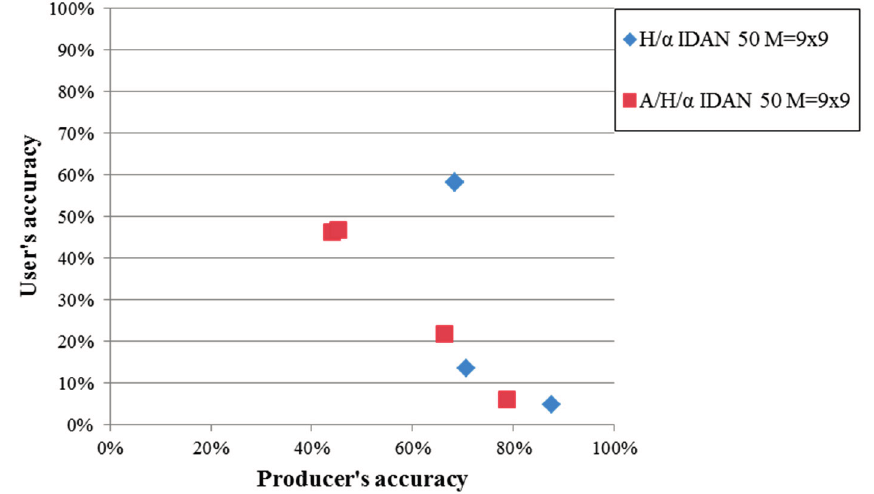
Figure 11. Development of user’s accuracy vs. producer’s accuracy for the OBIA improvements based on H/ α or A/H/ α , respectively (for the second TerraSAR-X acquisition (19 October 2010)). Processing steps from lower right to upper left: (1) pixel-based, (2) first s-e, (3) rule-set, (4) second s-e. Please notice that the third and fourth point are located very close to each other (valid for both, H/ α and A/H/ α ).